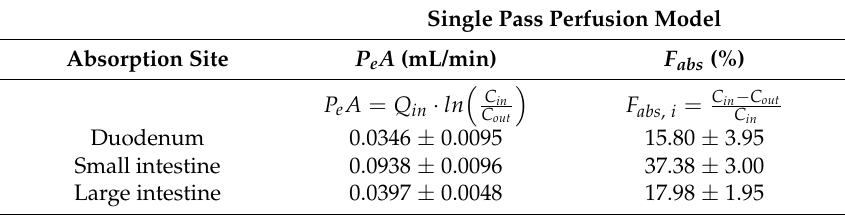
Figure 3. Regional absorption clearance ( P e A ) and the fraction absorbed ( F abs ) in the duodenum, small intestine, and large intestine in rats by the in situ single-pass perfusion ( n = 4, mean ± SD). P e A was calculated by Q · ln( C in / C out ), where Q is the perfusion rate, and C in and C out are the inlet and outlet concentrations, respectively. F abs was calculated by ( C in – C out )/ C in . Table 2. Absorption clearance ( P e A ) and fraction absorbed ( F abs ) of fimasartan in different gastrointestinal regions determined by single-pass perfusion ( n = 4, mean ±